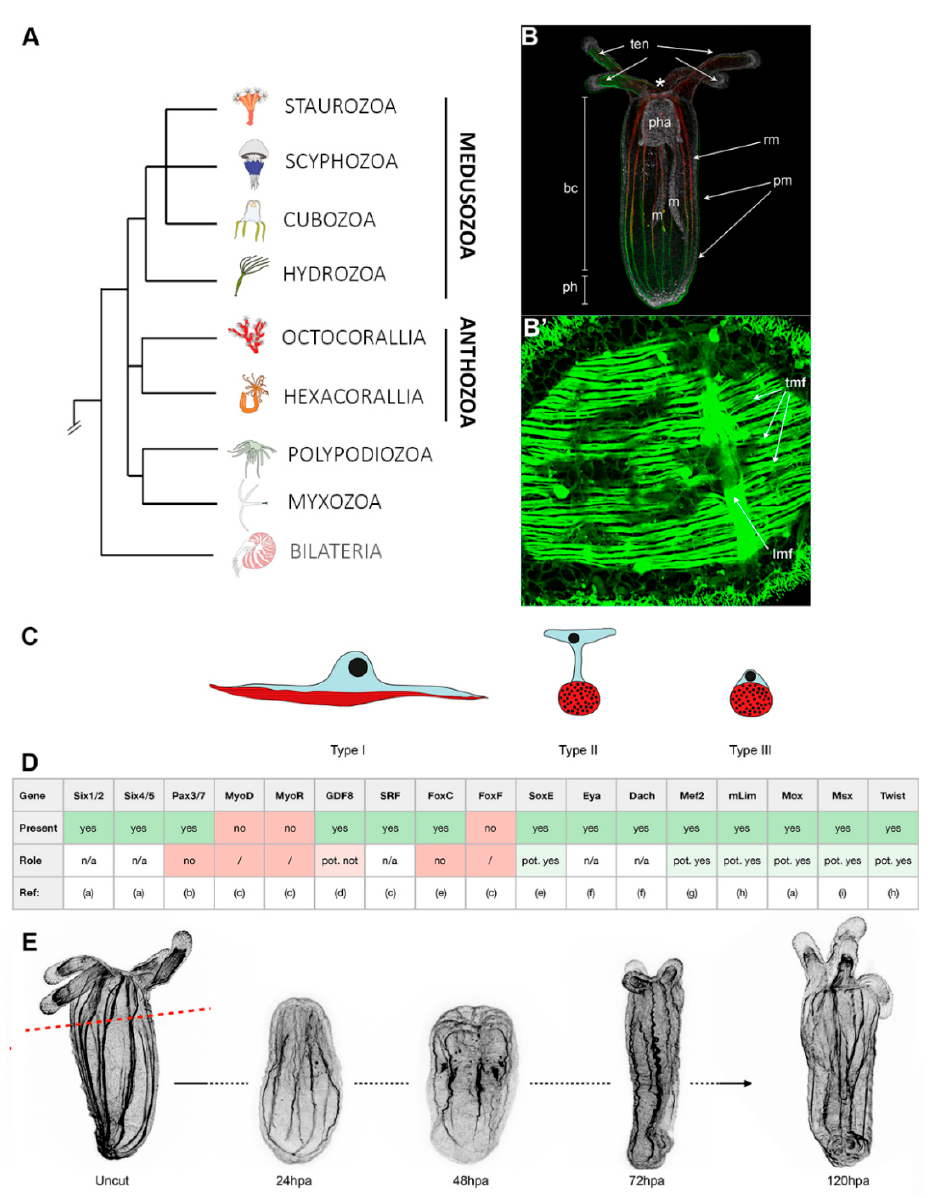
Figure 2. The epitheliomuscular system and regenerative capacity of the anthozoan cnidarian Nematostella vectensis . ( A ) Schematic representation of the relationship between the main cnidarian lineages and the phylogenetic position of Nematostella vectensis (Anthozoa, Hexacorallia). ( B ) The